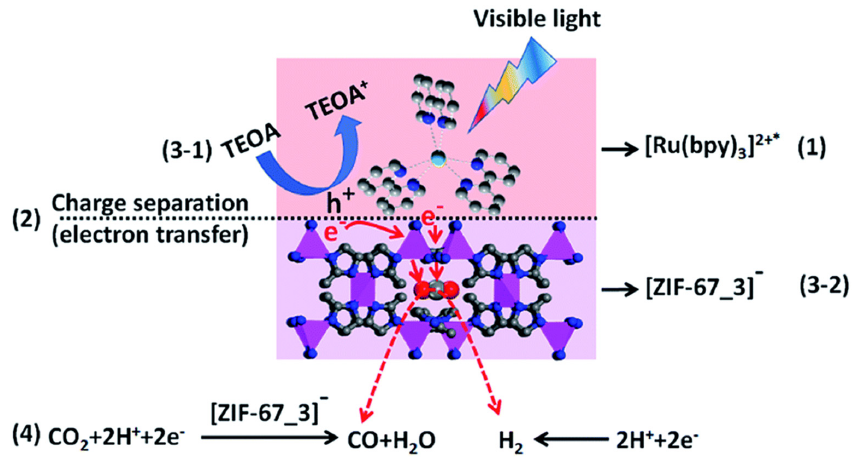
Figure 9. Possible reaction mechanism for the ZIF-67_3 co-catalysed photoreduction of CO 2 by employing [Ru(bpy) 3 ] 2+ and TEOA as the photosensitiser and electron donor, respectively. Reproduced with permission from [126]. Copyright 2018, the Royal Society of Chemistry.